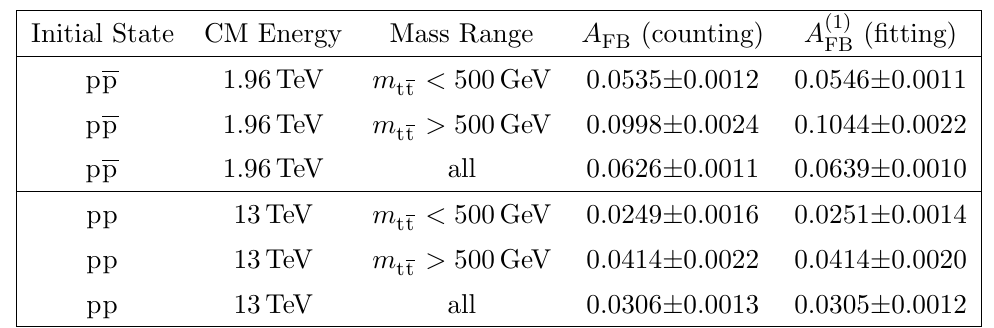
Table 1 . The accuracy of the linear approximation used to de(cid:12)ne A (1) the results of linear (cid:12)tting to determine A (1) and pp data samples are simulated with the NLO powheg generator [31] at center-of-mass (CM) energies of 1.96 TeV and 13 TeV,